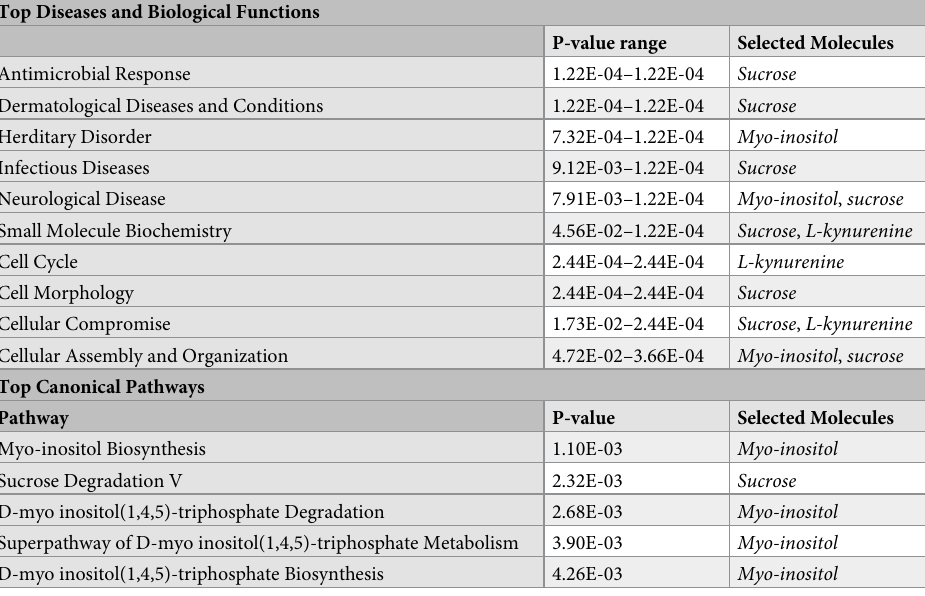
Table 5. Enrichment analysis of metabolites associated with COVID-19 status.